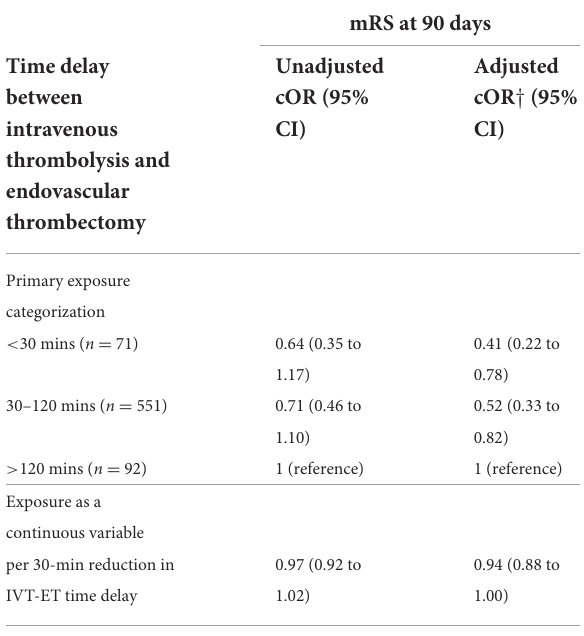
TABLE 2 Ordinal logistic regression results, effect estimates for IVT-ET time delay on mRS score 90 days after index acute ischaemic stroke